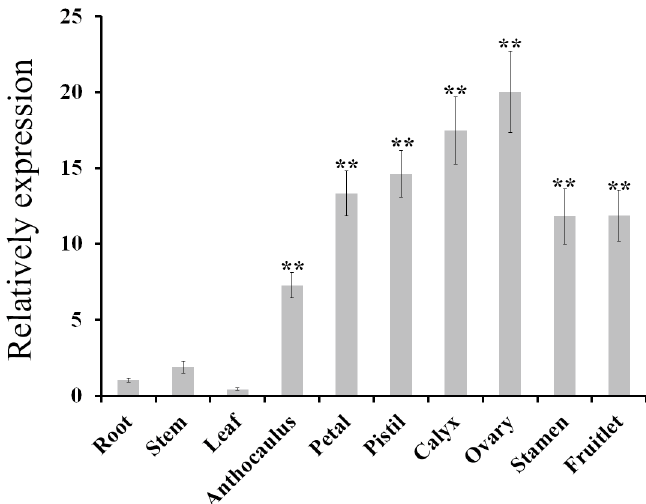
Figure 1. Expression pattern of AdPDC2 in different kiwifruit ( A. deliciosa ‘Jinkui’) plant tissues, including root, stem, leaf, anthocaulus, petal, pistil, calyx, ovary, stamen, and fruitlet (20 days after full blossom, DAFB) was assessed using qRT-PCR. AdActin was used as an internal control. Each column is the average of three replicates and each replicate has five plants. Bars indicate standard deviation (SD). Double asterisks indicate significant differences compared with root values (** p < 0.01).